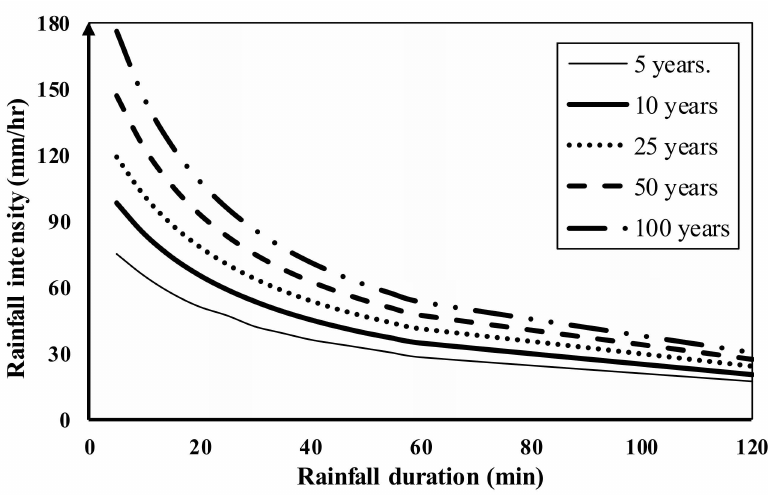
Figure 4. IDF curve for the study area (Dammam rainfall